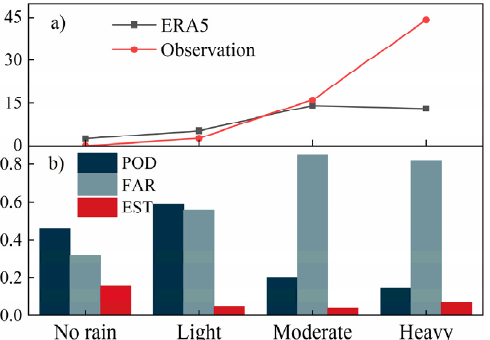
Figure 4. The ( a ) mean values of ERA5 data and of basin precipitation observations (mm/d), and ( b ) POD, FAR, and EST of ERA5, for four observed rain categories over the verification period (2007, 2008, Jun–Oct). POD = probability of detection; FAR = false alarm ratio; EST = equitable threat score; the four categories are: no rain (<0.1 mm/d), light precipitation (0.1–10 mm/d), moderate precipitation (10–25 mm/d), and heavy precipitation (25–50 mm/d).